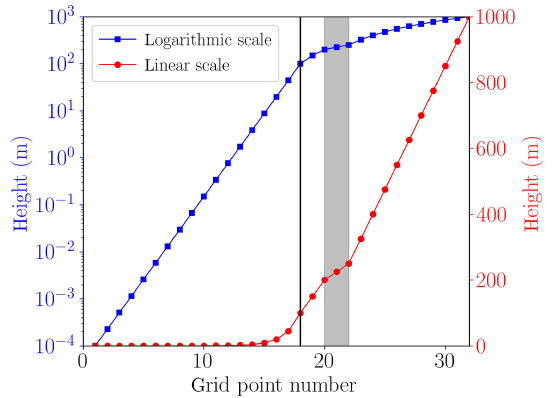
Figure 3. Numerical grid with M = 32 grid cells (cf. Fig. 2) plotted on a logarithmic scale (squares) and a linear scale (filled circles). The grey area shows the inversion